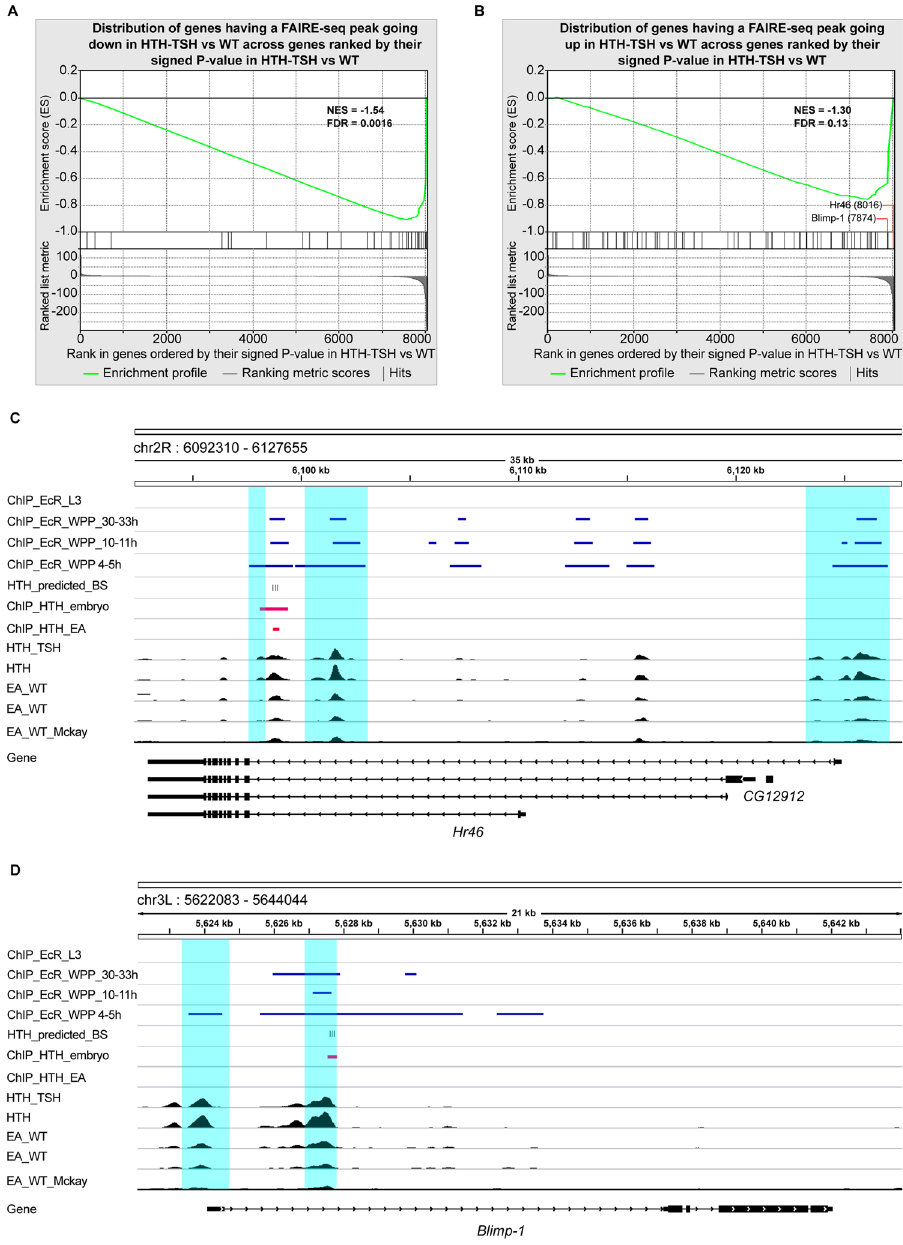
Figure 4. FAIRE-seq open chromatin profiling of hth + tsh cells. ( A ) Gene Set Enrichment Analysis (GSEA, ref. 100) compares gene expression changes with open chromatin changes. In the x-axis are all genes, ranked by the significance p-value of differential expression of control versus hth + tsh samples, with genes down-regulated in hth + tsh on the left, and genes up-regulated on the right. The tested gene sets (shown as black vertical lines) are genes with nearby (in 5 kb upstream and intronic space) FAIRE-seq peaks showing significant decreased accessibility . The correlation between both is highly significant (FDR < 0.001). ( B ) Similar plot, comparing changes in gene expression with genes showing nearby FAIRE-peaks with increased accessibility . In this case, the correlation is not significant, but the most down-regulated nuclear receptors Hr46 and Blimp-1 (indicated) are among the few genes showing peaks with increased accessibility. ( C , D ) Genomic view of Hr46 ( C ) and Blimp-1 ( D ) showing FAIRE-seq open chromatin profilling data for optix > hth + tsh (“HTH_TSH”), optix > hth (“HTH”) and control eye-antennal discs (EA) (EA_WT: black wiggle plot tracks); Hth ChIP-seq target regions in embryo and EA disc are shown with a red line; HTH-TSH versus WT differentially open chromatin peaks are highlighted with a cyan background; and prediction of binding sites within Hth ChIP peaks are shown as black ticks marked as “HTH_predicted_BS” (Cluster-Buster) 104 motif score > 6 using FlyFactorSurvey PWMs). In addition, ModENCODE EcR ChIP data are shown with a blue line, for L3 (modEncode_2640), WPP 4–5 h (modEncode_3398), WPP 10–11 h (modEncode_2641), WPP 30–33 h